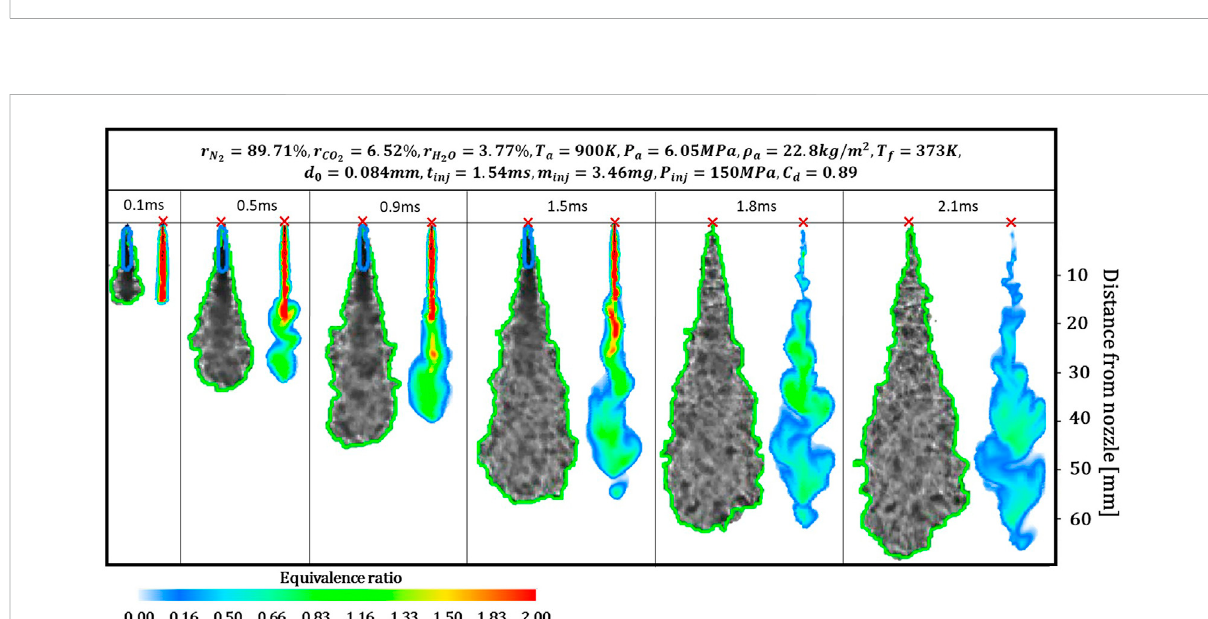
FIGURE 2 Spray shapes and equivalence ratio histories at 440 K ambient